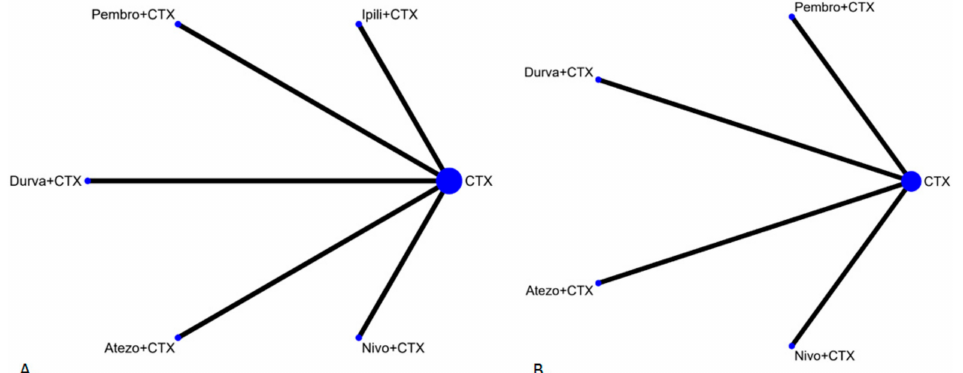
Figure 2. Network construction. ( A ) Network constructions for comparison in overall survival and grade 3–4 adverse events; ( B ) Network constructions for comparison in progression free survival and objective response